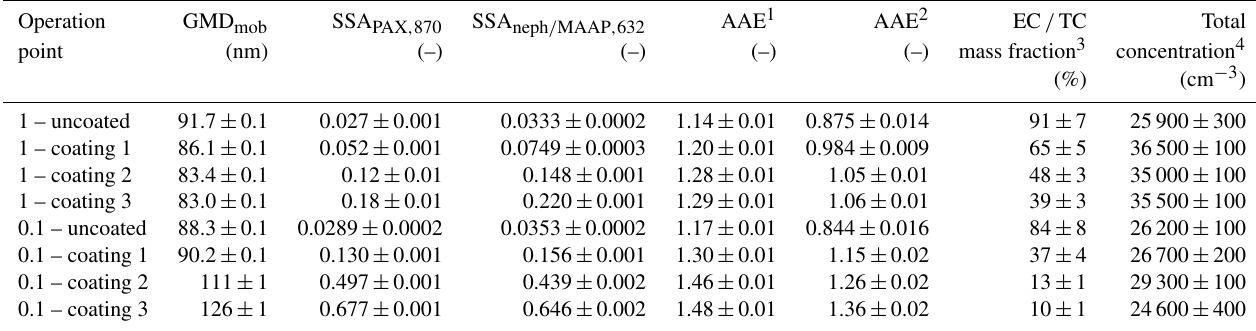
Table 1. Physicochemical properties of the uncoated and coated soot particles generated in this study. The uncertainties for the GMD mob , total concentration, SSA, and AAE correspond to 1 standard deviation of the mean ( k = 1; 68% confidence interval; number of measurements n = 100–180 for SSA and AAE, n = 29–35 for GMD mob and total concentration). Operation